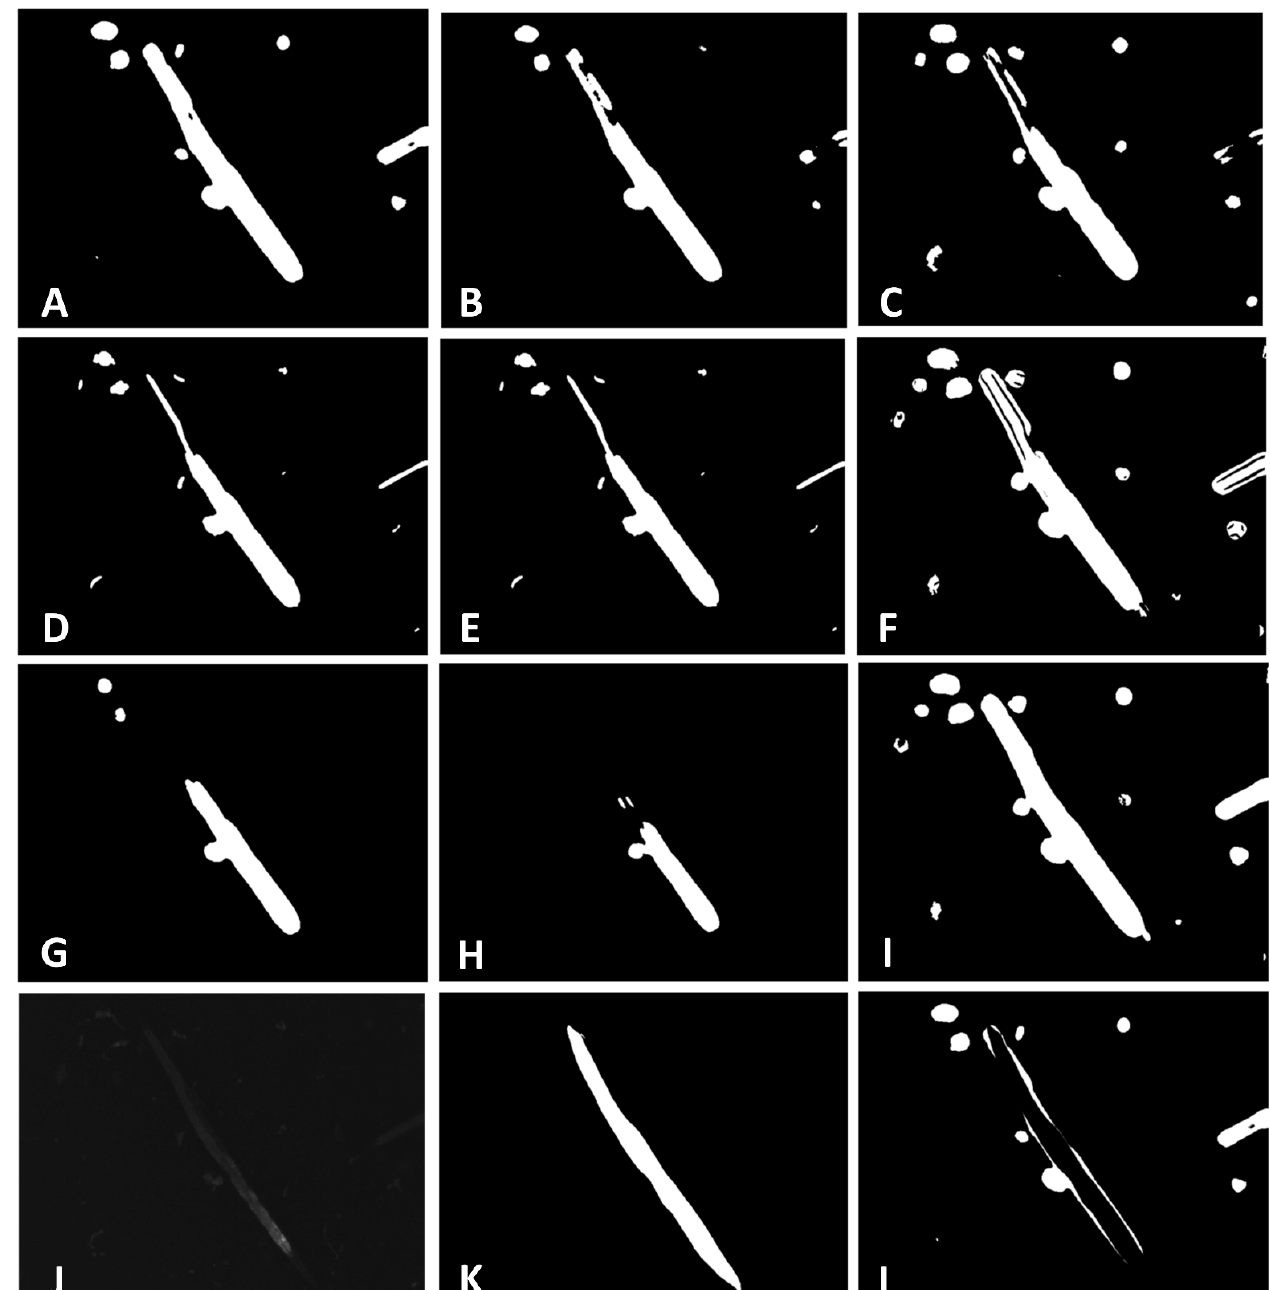
Figure 3. ( A – H ) Classification results of classifiers with different subsets; ( I ) all available filters; ( J ) original worm image; ( K ) mask created by manual classification; ( L ) false positive (FP) areas after classification based on Subset 1.